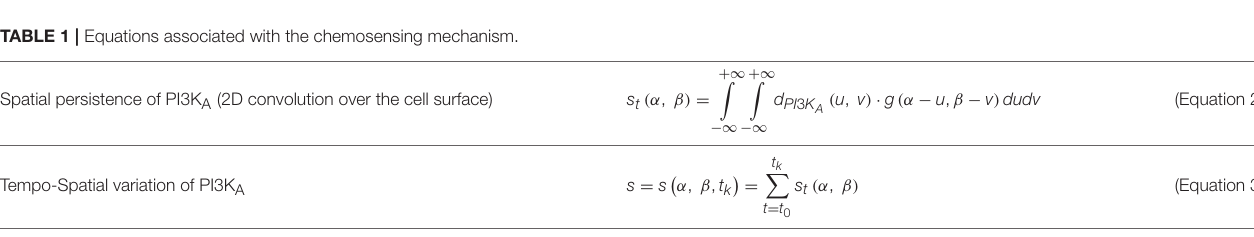
FIGURE 2 | (Left) spherical coordinates ( α , β ) of point q . (Right) s signal distribution example over the cell membrane.